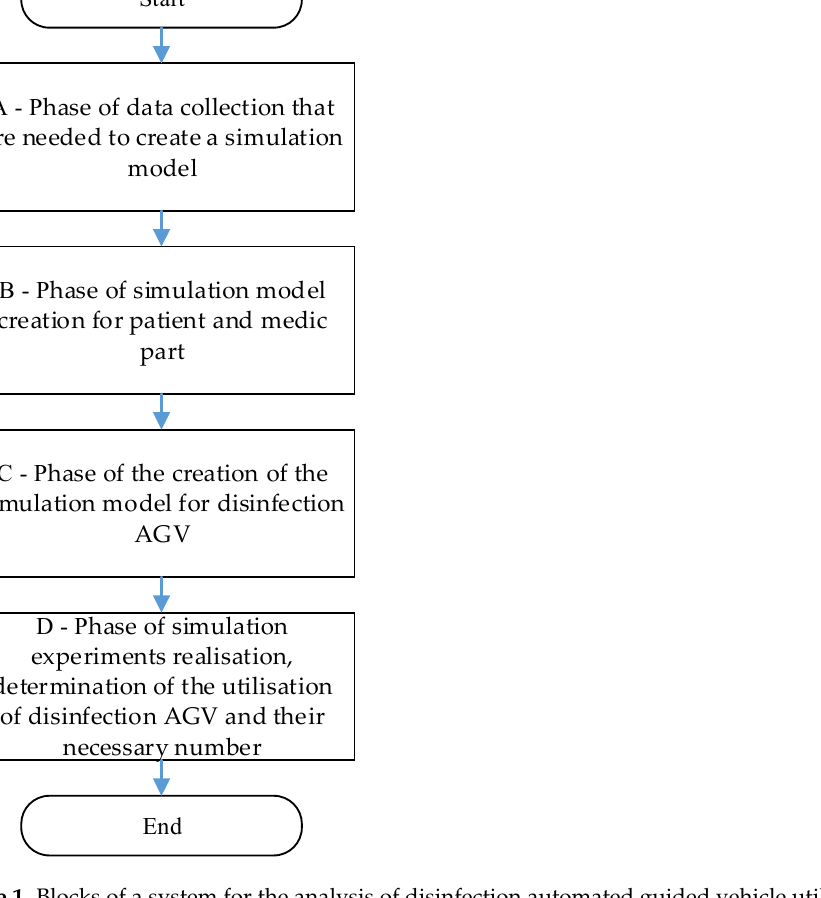
Figure 2. Block A phase of data collection needed to create a simulation model.